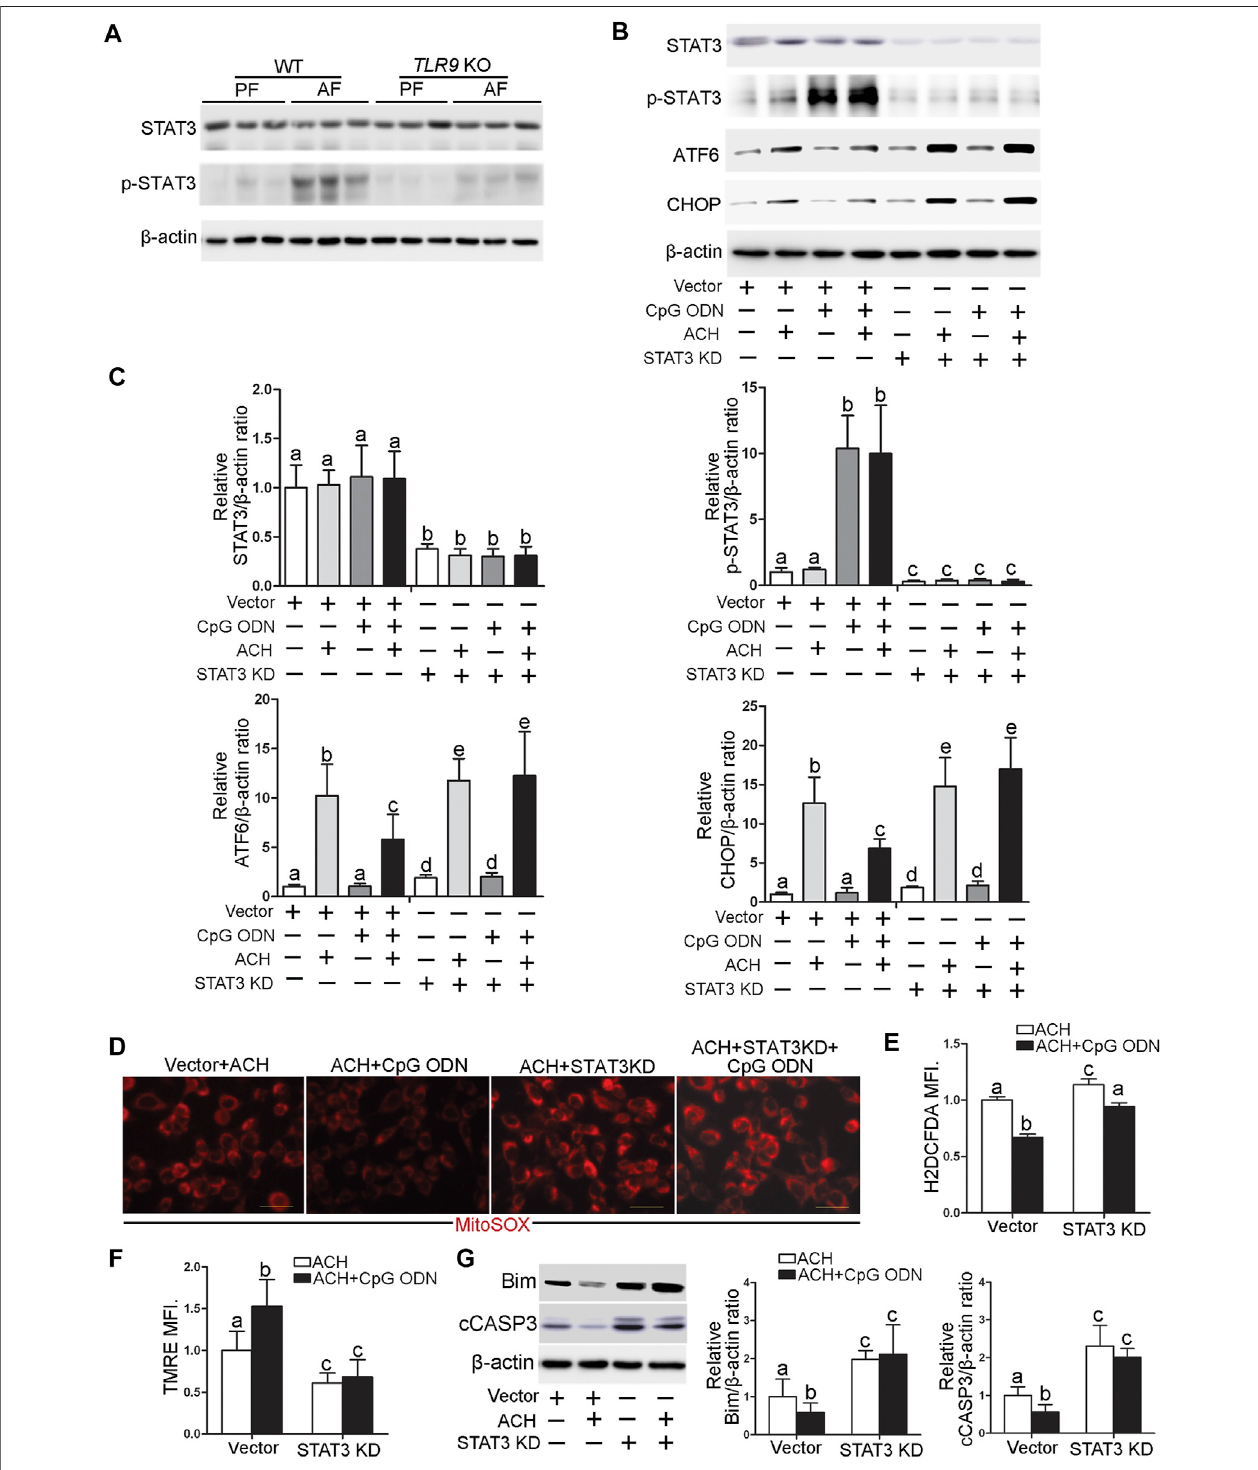
FIGURE 7 | TLR9 control ATF6-CHOP axis expression via regulating STAT3 activation in hepatocyte. (A) TLR9 KO and wild-type male mice were pair-fed or alcohol-fed for 8 weeks plus a single binge of ethanol (4 g/kg) before 4 h of tissue collection. Hepatic STAT3 and p-STAT3 protein levels in mice. (B,C) Protein levels of STAT3, p-STAT3, ATF6, and CHOP in STAT3 knockdown AML12 cells. (D) Immuno fl uorescent staining ofmitochondrial ROS using MitoSOX probe. (E) FACS analysis of total ROS using H2DCFDA dye. (F) FACS analysis of mitochondrial membrane potential using TMRE dye. (G) Protein levels of Bim and cCASP3. Data are presented as means ± SD. Statistical comparisons were made using one-way ANOVA with Tukey ’ s post hoc test. Bars with different characters differ signi fi cantly ( p < 0.05).